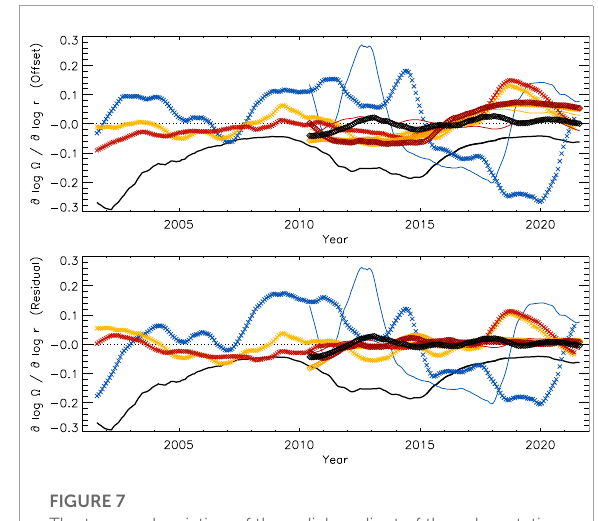
FIGURE 7 The temporal variation of the radial gradient of the solar rotation rate averaged in latitude over ± 52 . 5° at three depths (blue: .997 R ⊙ , yellow: .990 R ⊙ , red: .983 R ⊙ ) using 15°-tile RDA (crosses: GONG, solid lines: HMI) and averaged over ± 45 . 0° at three depths (yellow: .990 R ⊙ , red: .983 R ⊙ , black: .960 R ⊙ ) using 30°-tile RDA (diamonds: HMI) after subtracting the temporal mean (top) and subtracting the linear fit to the corresponding average of the mean activity index, MAI, (bottom). The temporal variation of the average MAI is included for comparison with its sign reversed and divided by 50 (black solid line). All curves were smoothed with a rectangular boxcar over 13